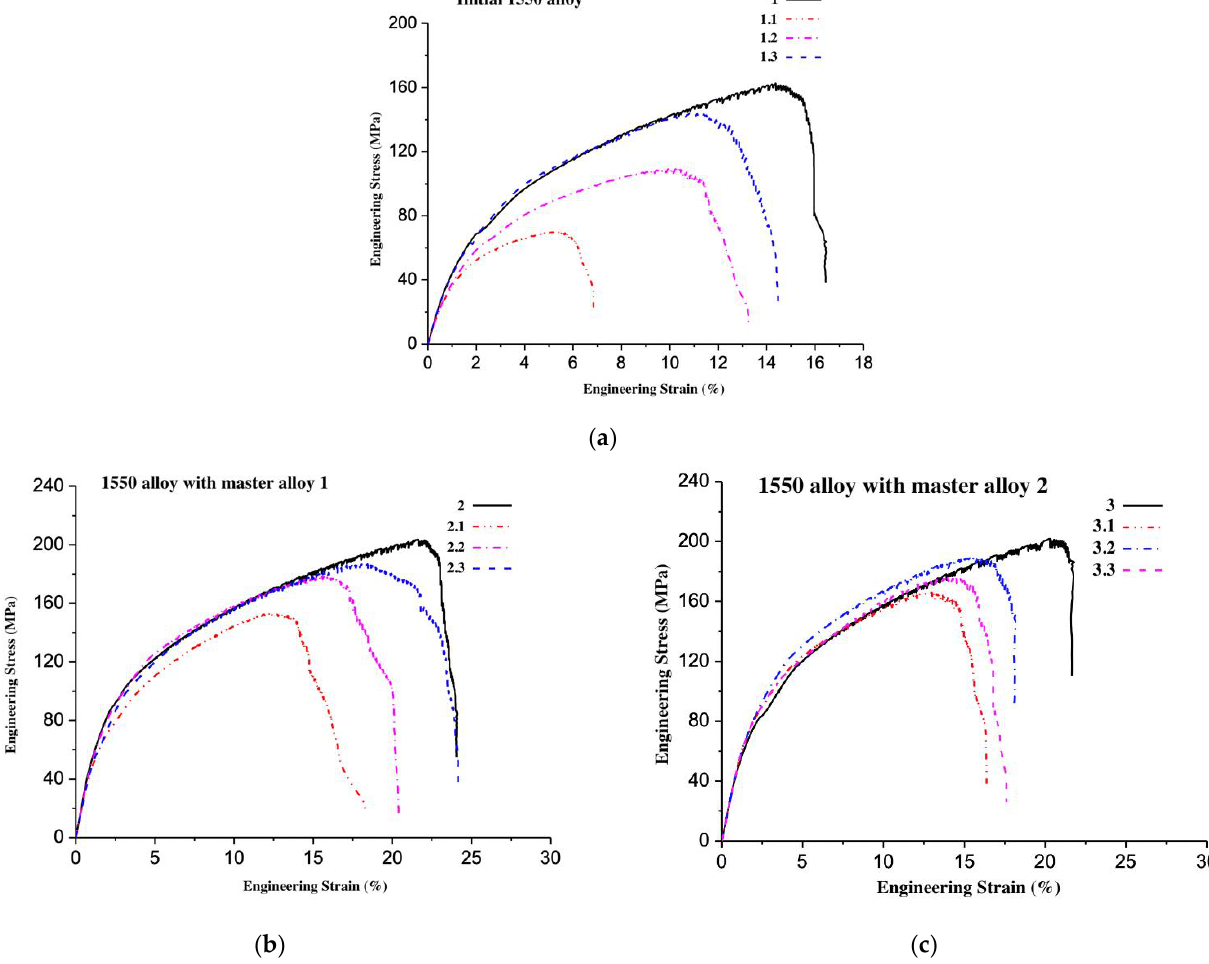
Figure 6. Stress–strain curves for the initial ( a ) and reinforced ( b , c ) 1550 alloy; 1, 2, 3—alloys without welding; 1.1, 1.2, 1.3; 2.1, 2.2, 2.3; 3.1, 3.2, 3.3—studied alloys with varying welding depth. Table 3. Mechanical characteristics of the studied